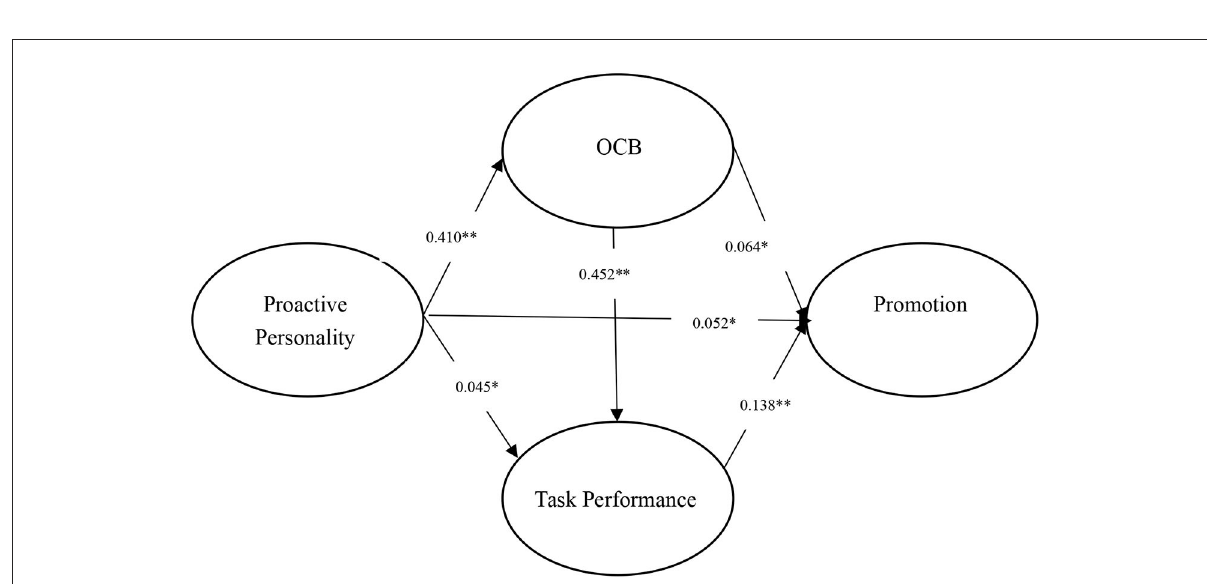
FIGURE4 Results of MASEM for proactive personality and promotion. ** p < 0.01; * p <